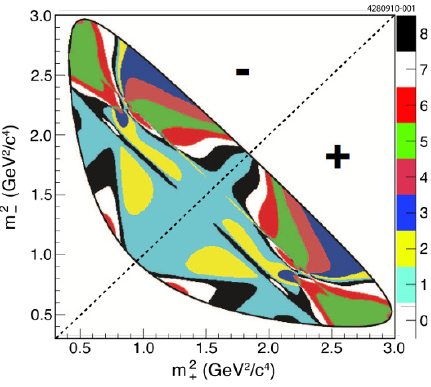
Figure 1 . The equal (cid:1) (cid:14) D binning from ref. [21]. The absolute bin number, j i j , is indicated by the colouring. The positive bins are de(cid:12)ned in the region m 2 region m 2 < m 2 + (cid:0)